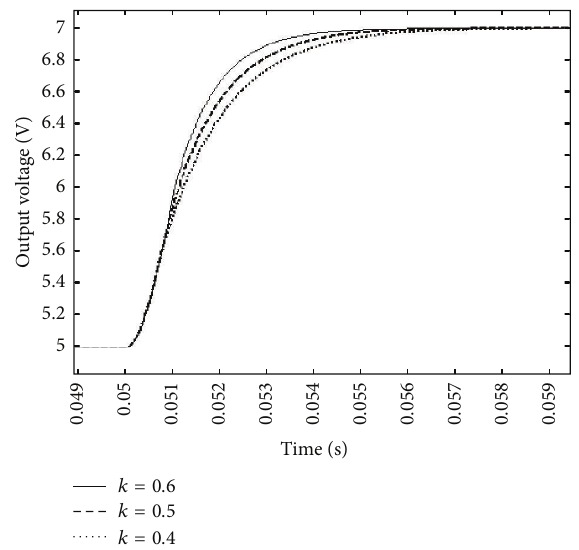
Figure 9: The DC/DC output voltage variation about reference variation time.